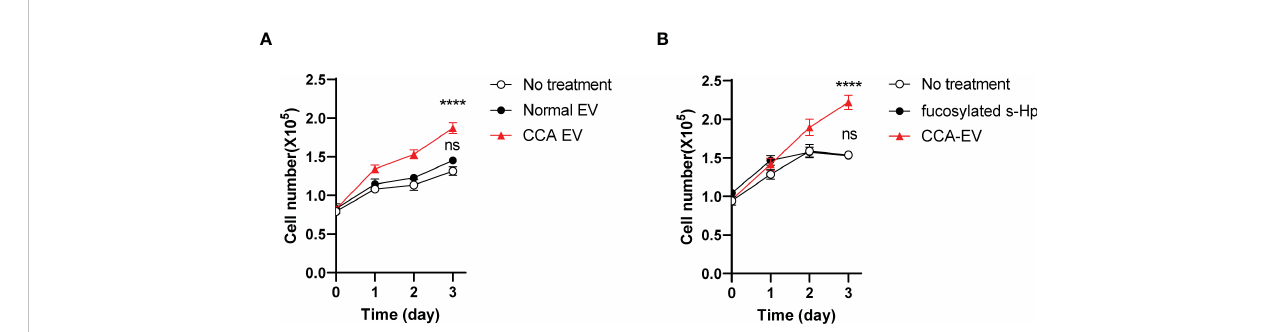
FIGURE 8 Fucosylated EV promotes CCA progression. Quantitative data are shown as mean ± S.E.M. Statistical analysis was performed using the two-tailed Student ’ s t-test: ****p<0.0001, ns p>0.05. (A) The effect of CCA EVs on the growth of SNU-1079 cells, n=3. (B) The impact of fucosylated soluble- Hp on cell growth, n=3. ns, not signi fi